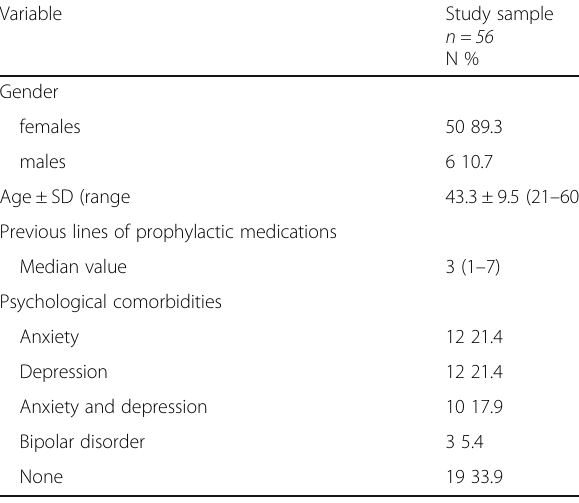
Table 1 Patients ’ baseline data and clinical characteristics Variable Study sample